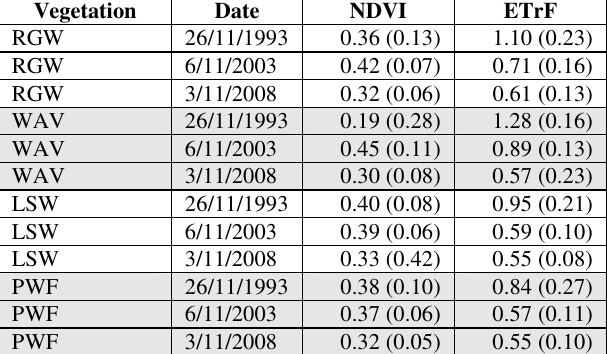
Figure 3. Change in NDVI between 27/11/1993 and